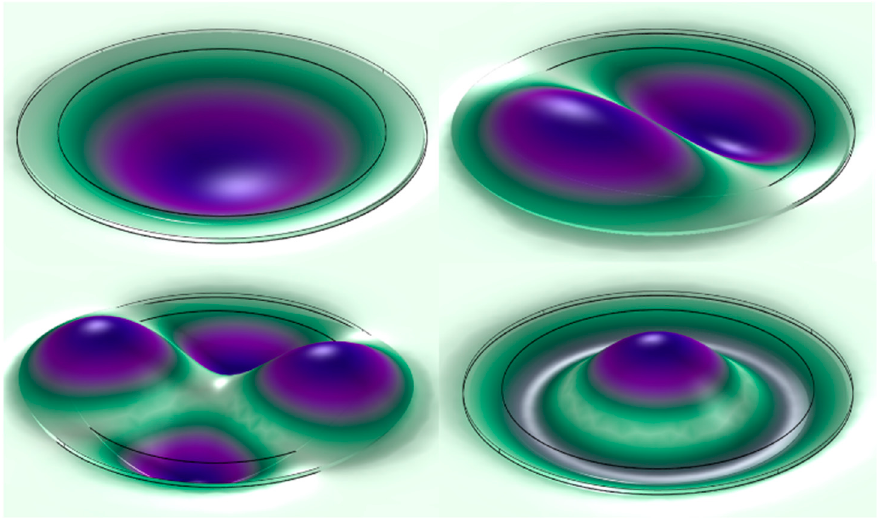
Figure 4. Mode shapes of the first four modes of PMUT.